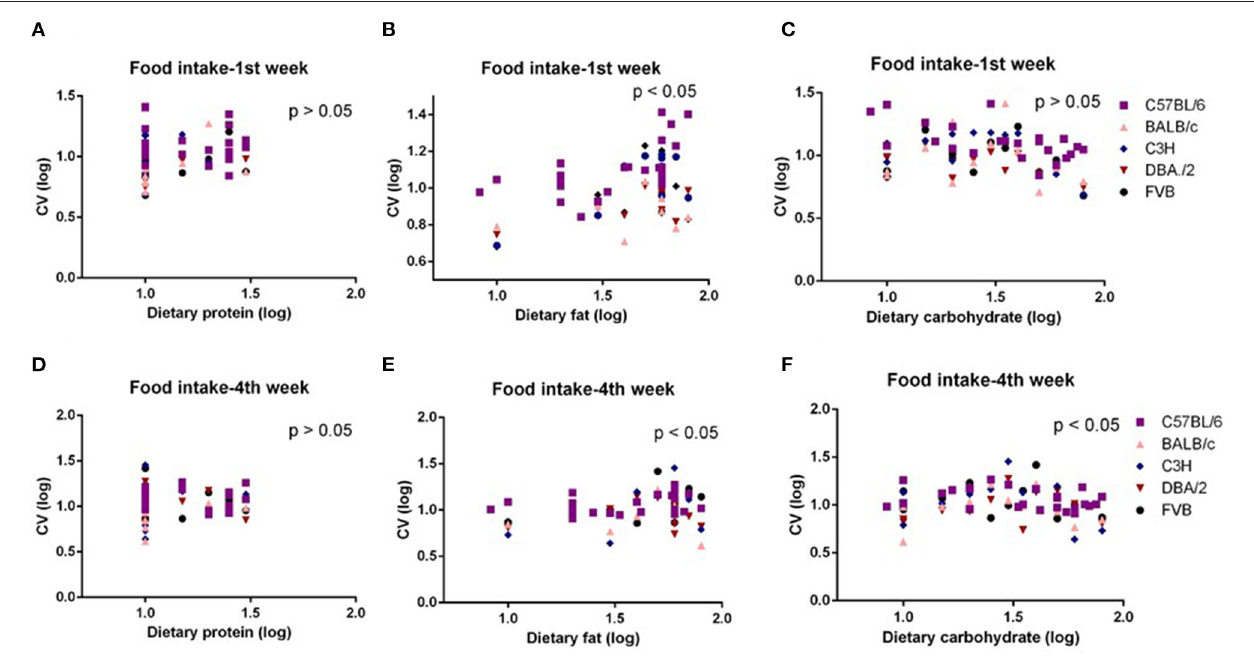
FIGURE 5 | The diagram showing the relationship between dietary macronutrient content and coefficient of variation (CV) of food intake of the 1st week and 4th week after exposure to different diets. The correlations between logged dietary fat, protein, and carbohydrate contents and (A–C) logged CV of food intake of the 1st week and (D–F) 4th week at different diet treatment periods, respectively ( n = 7–21).